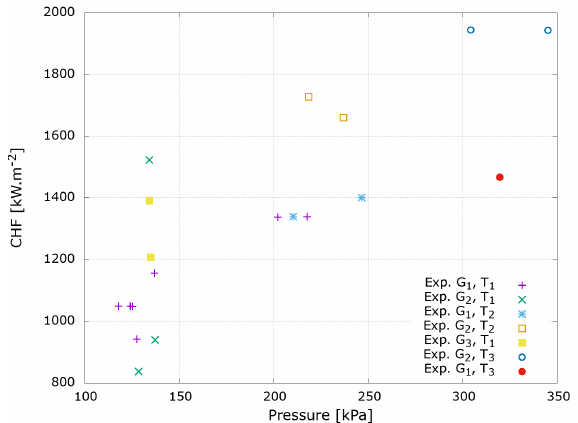
Figure 5. CHF against inlet pressure with different inlet mass flux and temperature according to Tab. 2.